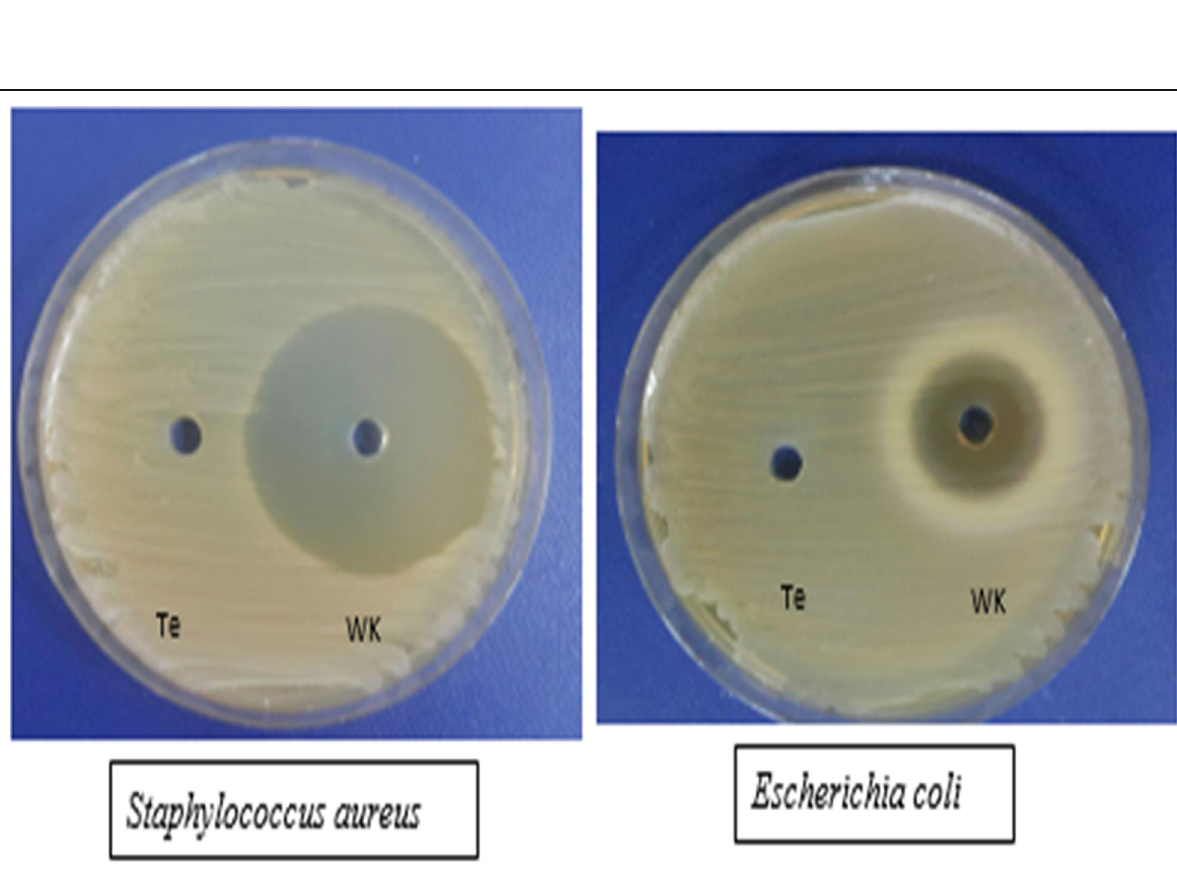
Fig. 4 Antimicrobial activity of WK for Wickerhamomyces anomalus against Staphylococcus aureus and E.coli at a concentration of 200